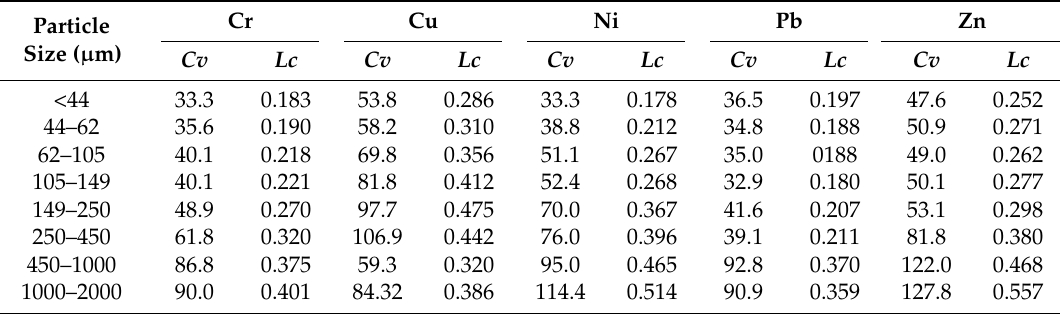
Table 2. A comparison of two methods (the coefficient of variation, Cv , and the Lorenz coefficient, Lc ) to quantify the grain-size class heterogeneity in metal concentration in